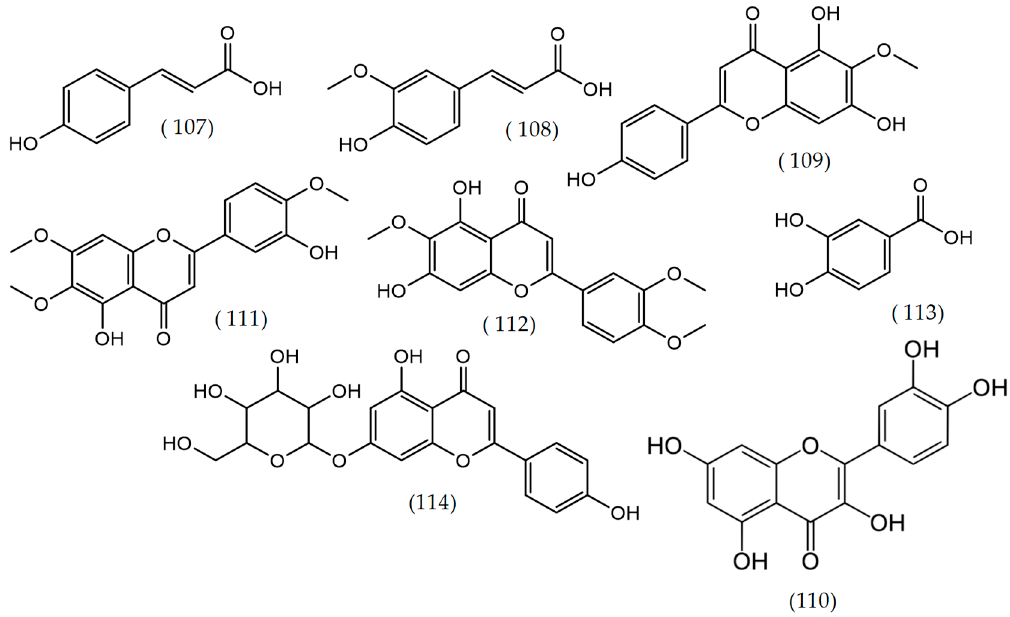
Figure 16. Structures of compounds reported in several Veronica species: Veronica officinalis, Veronica ciliata, and Veronica rosea .